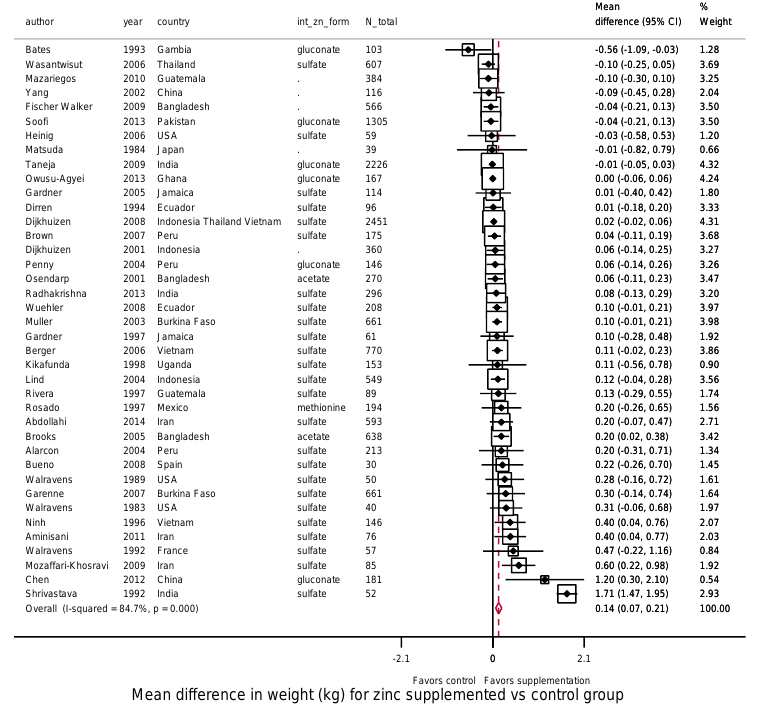
Figure 3. Effect of zinc supplementation among children aged < 5 y old on weight in randomized F igure 3: Effect of zinc supplementation among children aged<5 y old on weight in randomized controlled controlled trials.